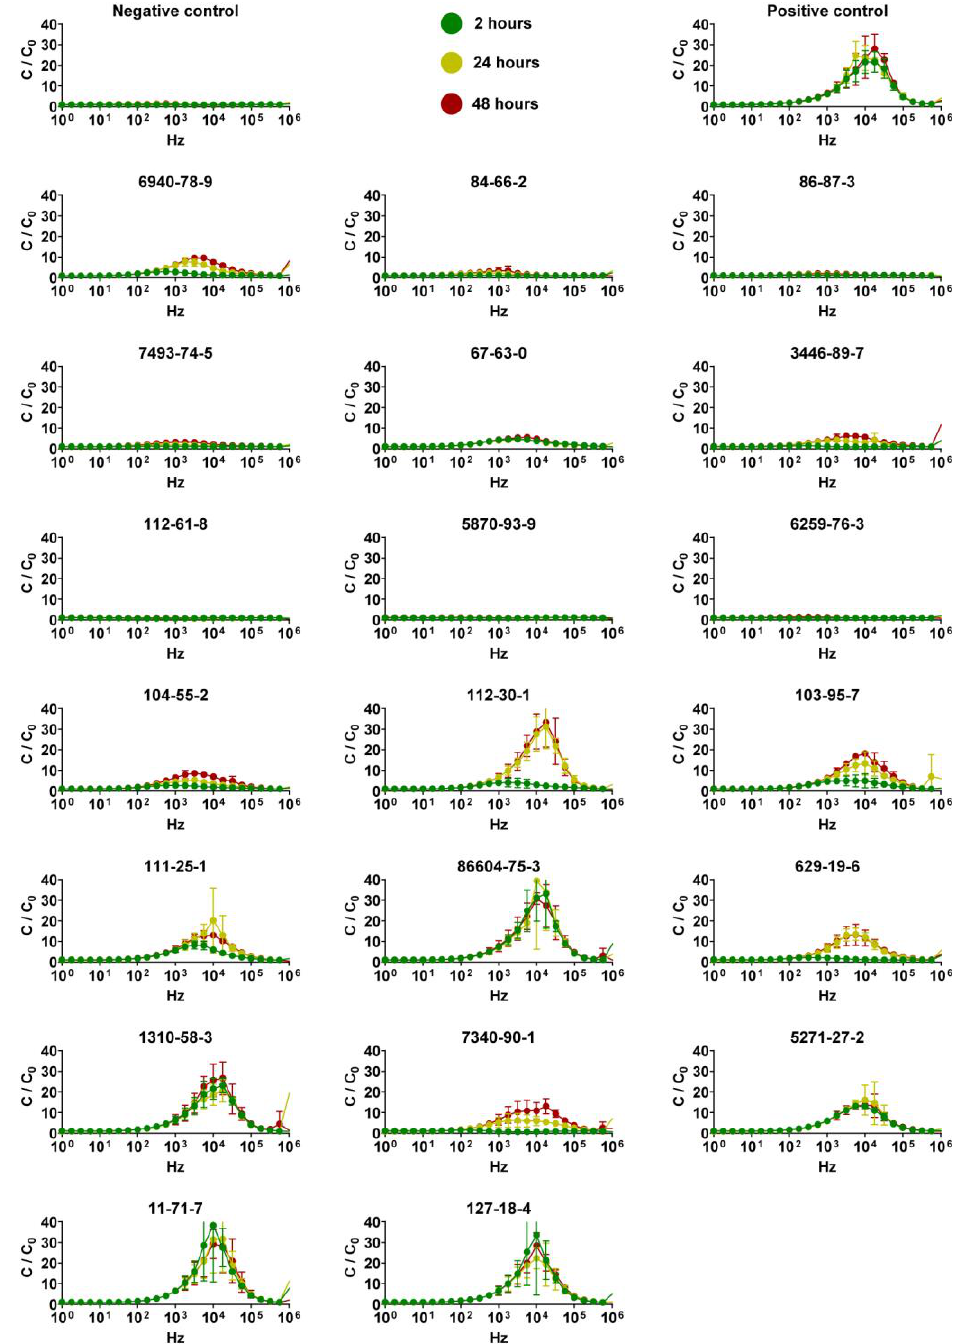
Figure 5. Determination of optimal frequency using a frequency dependent spectrum. Data are presented as normalized capacitance ( y -axis) versus frequency ( x -axis) measured at 2, 24, and 42 h. Data are shown as mean ± SD; n = 3. Table 3. Normalized capacitance data at 17 kHz after chemical exposure.